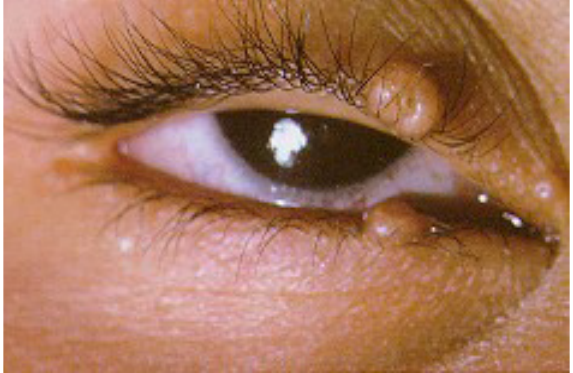
Figure 3. Molluscum contagiosum lesions in a HIV negative child (Photo Courtesy of Dr Linda